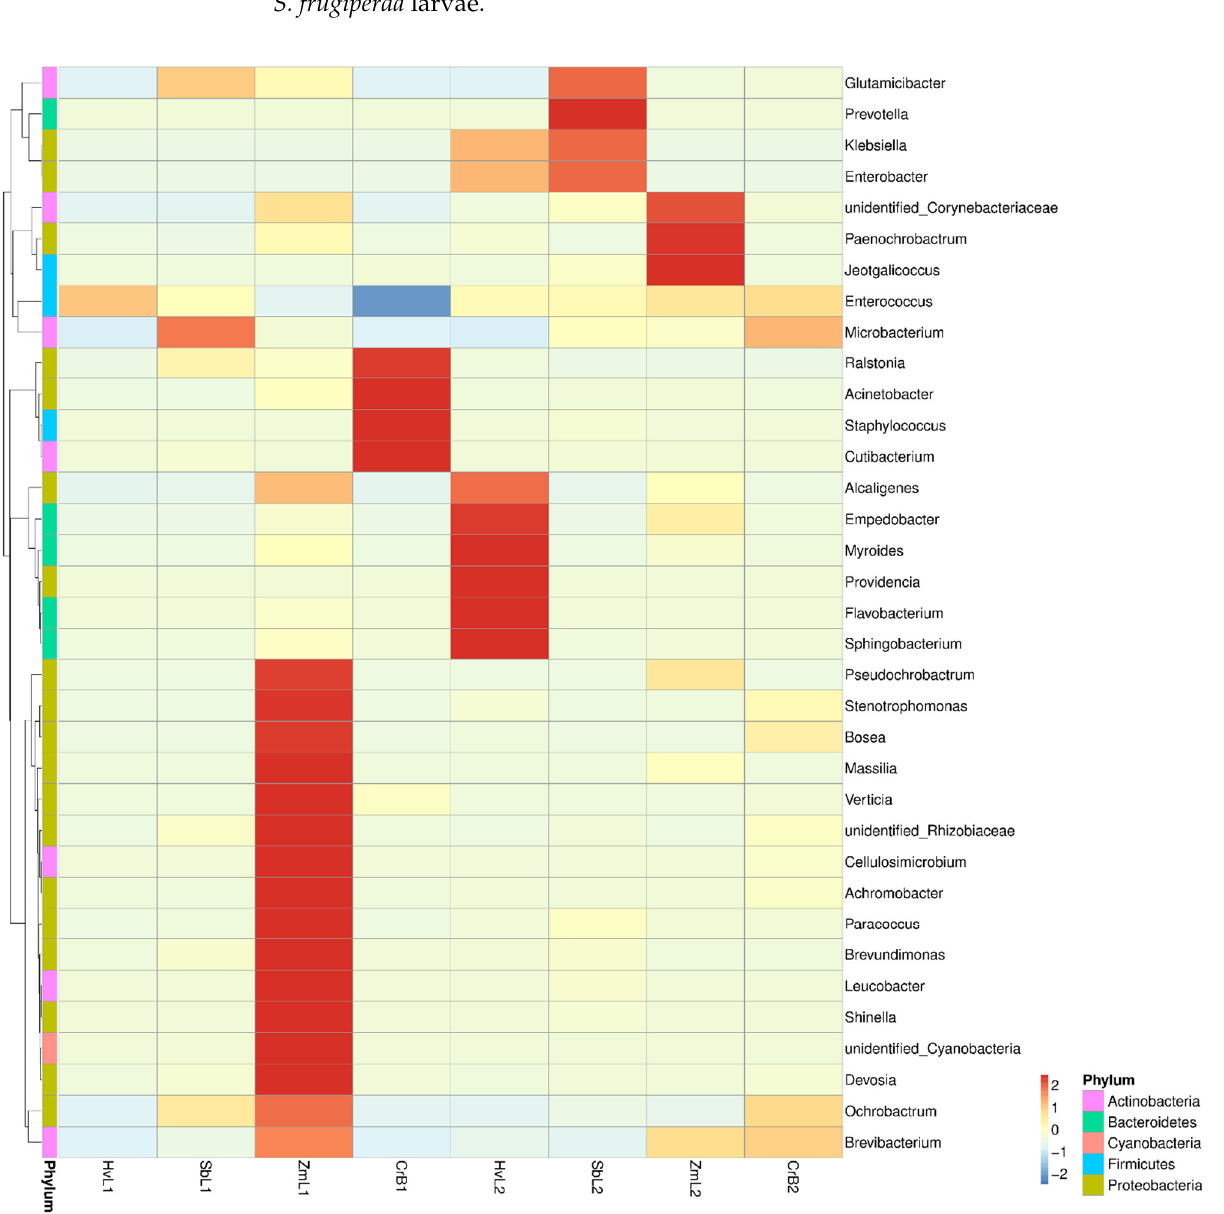
Figure 6. Heat map of relative abundances of the top thirty-five predominant genera of gut bacteria separated by phylum in S. frugiperda larvae fed on leaves of different host plants. Treatment names are on the x -axis, and genus annotation is on the y -axis. The clustering tree for genera is on the left, and heat map values are Z-values obtained after relative abundances of each genus were